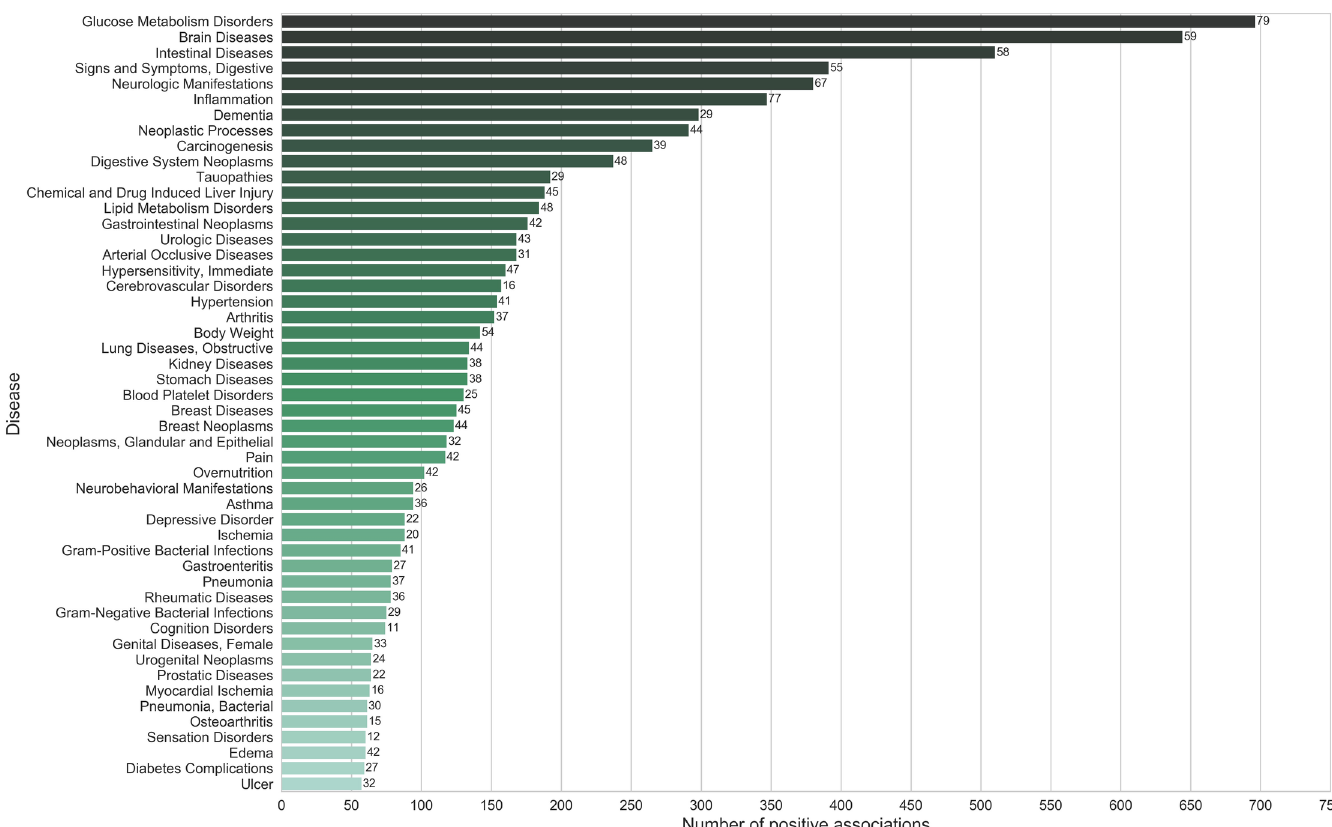
Fig 4. Top diseases (Third level of MeSH hierarchy) ranked according to their total number of positive associations. Numbers shown against the bars indicate the ‘number of spices’ involved in the associations. The number of positive disease associations for spices outnumber the number of negative associations (Fig 5) indicating that spices, in general, have been reported with beneficial health